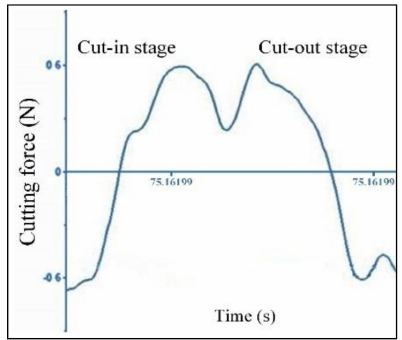
Figure 8. The cutting force signal of single cutting pass ( f z = 0.22 µ m, a p = 5 µ m, n = 16,000